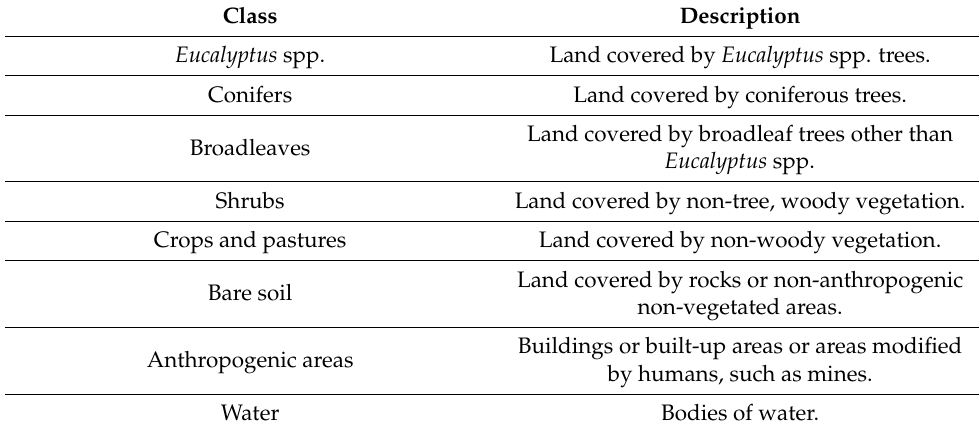
Figure 5. Diagram of the methodological approach followed to obtain the forestry-oriented land cover map of Galicia. Table 1. Description of target land cover